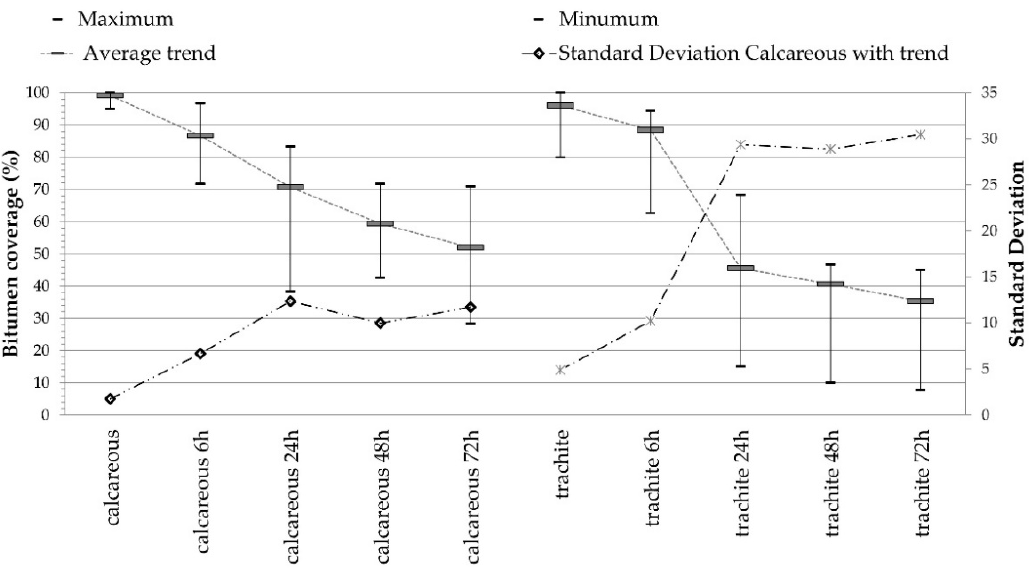
Figure 4. Bitumen coverage trend obtained via visual inspection. The plot shows the minimum,